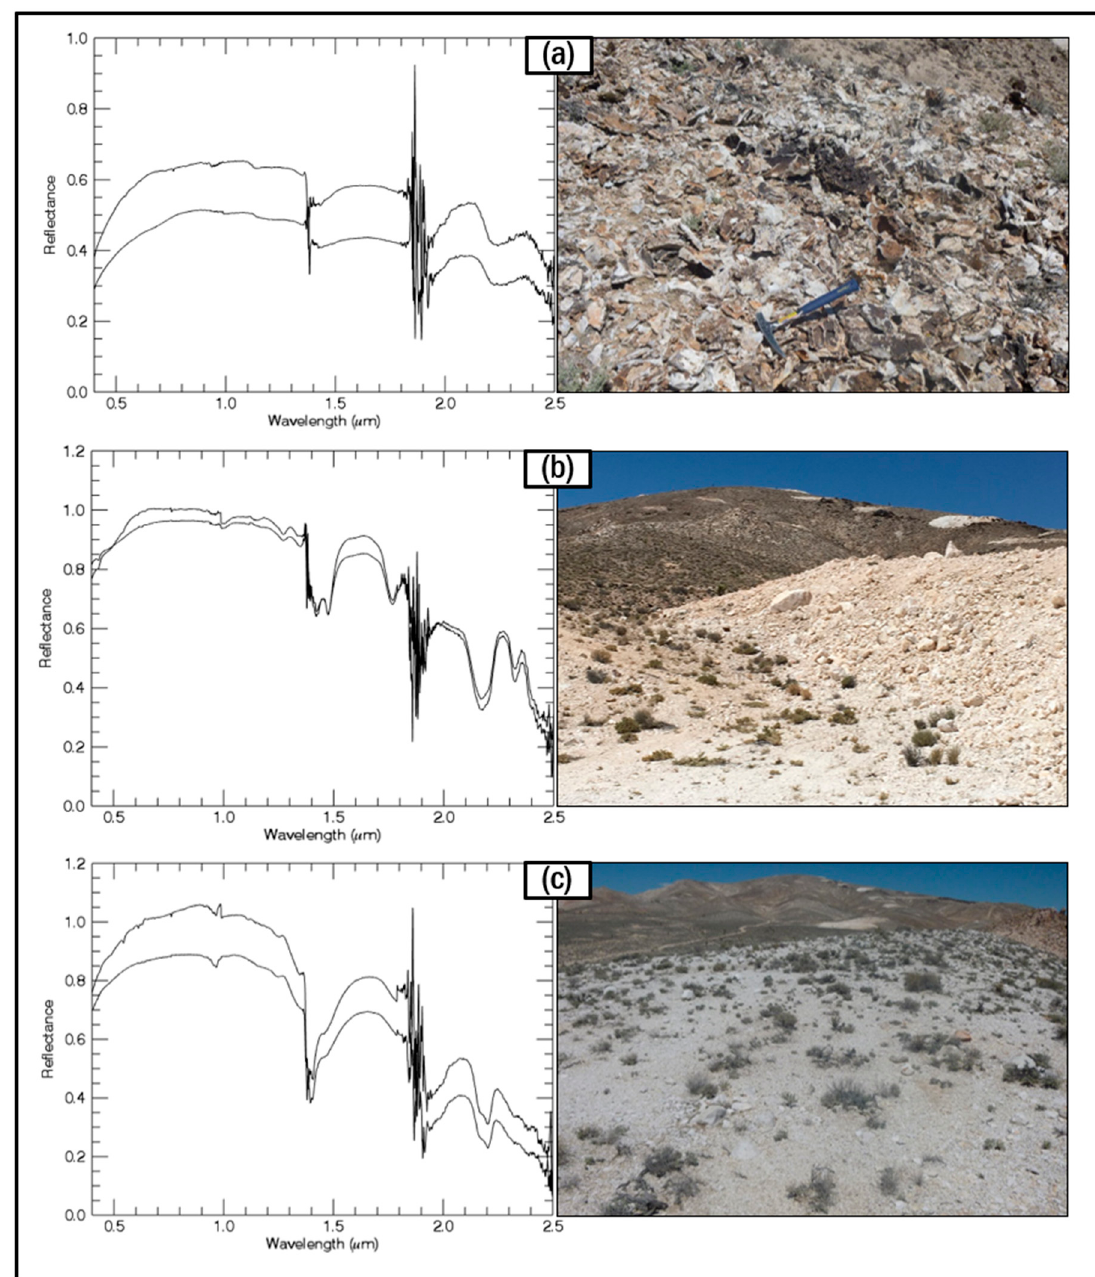
Figure 9. Reflectance spectra and outcrop photographs of the hydrothermal alteration zone in Cuprite. See the locations in Figure 8. The upper and lower spectra for each sample indicate measurements for the fresh surface and the weathered surface, respectively. Absolute reflectance values are not meaningful due to imprecise measurement conditions. The noisy patterns at around 1.4 and 1.9 microns are due to the atmospheric water vapor as these spectra were obtained outdoor by using sunlight as an illumination source. ( a ) Silicified rock with chalcedony at the center of the alteration zone, ( b ) hydrothermally altered rock that includes alunite, and ( c ) hydrothermally altered rock that includes kaolinite.